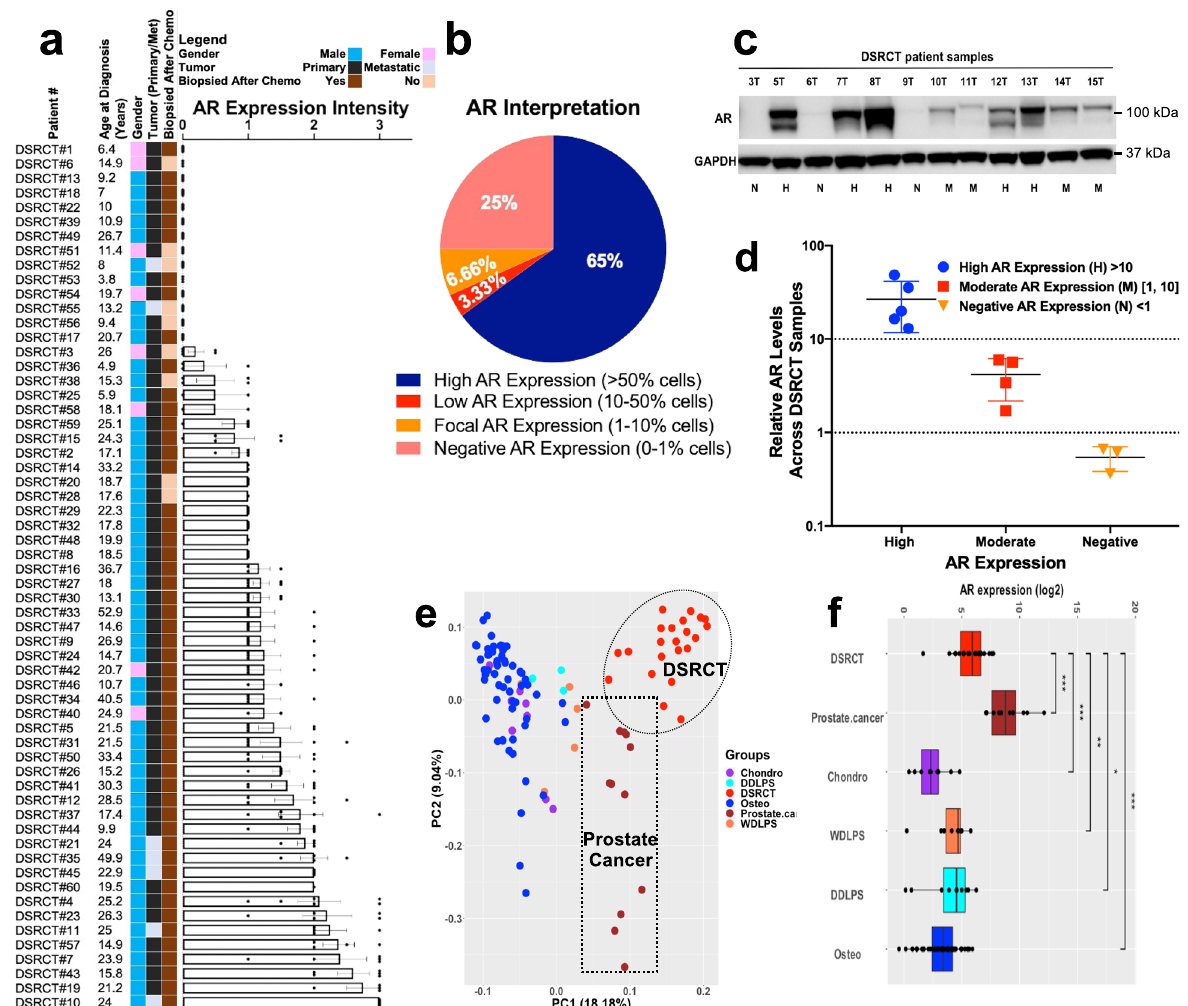
Fig. 2 DSRCT TMA and frozen specimen pro fi ling for AR and PSA expression. a A histogram showing the AR IHC expression levels of 60 human DSRCT tumors grouped by intensity (low, moderate, and high). The demographic data, including the corresponding gender (red: male or green: female), the age at diagnosis, and the pre/post-chemotherapy treatment to the surgery of each primary or metastatic resected tumor patient, are displayed at the left of each histogram. b AR expression level interpretation on DSRCT TMA IHC-stain and percentage scoring of tumoral labeling (positive (>50%), low positive (10 – 50%), focal (1 – 10%), and negative (0 – 1%)). c Western blotting analyses of AR expression in 11 DSRCT snap-frozen primary tumors. AR expression: P = positive, N = negative, or M = moderate. d Relative AR levels across samples shown in c . Bars show mean ± SD. e The principal components analysis plot performed on gene expression from prostate cancer (PC), DSRCT, and additional type of sarcomas samples. f Boxplot for the AR gene expression level across DSRCT, prostate cancer, and four other sarcoma types. The Wilcoxon rank-sum test performed to compare the AR levels between DSRCT ( n = 22) and each of the other cancer types. PC = prostate cancer ( n = 12); CS = chondrosarcoma ( n = 7); OS = osteosarcoma ( n = 47); WDLPS = well- differentiated liposarcoma ( n = 7), and DDLPS = dedifferentiated liposarcoma ( n = 10). *** p value < 0.001, ** p value < 0.01, and * p value <